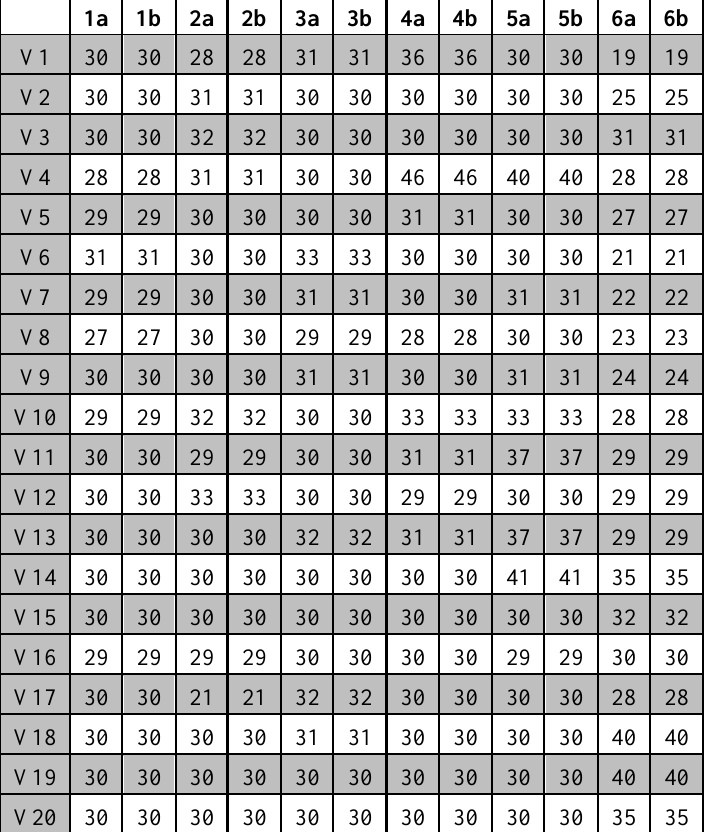
Table 1. A number of repetitions of each movement for each activity and for each volunteer (V1 ÷